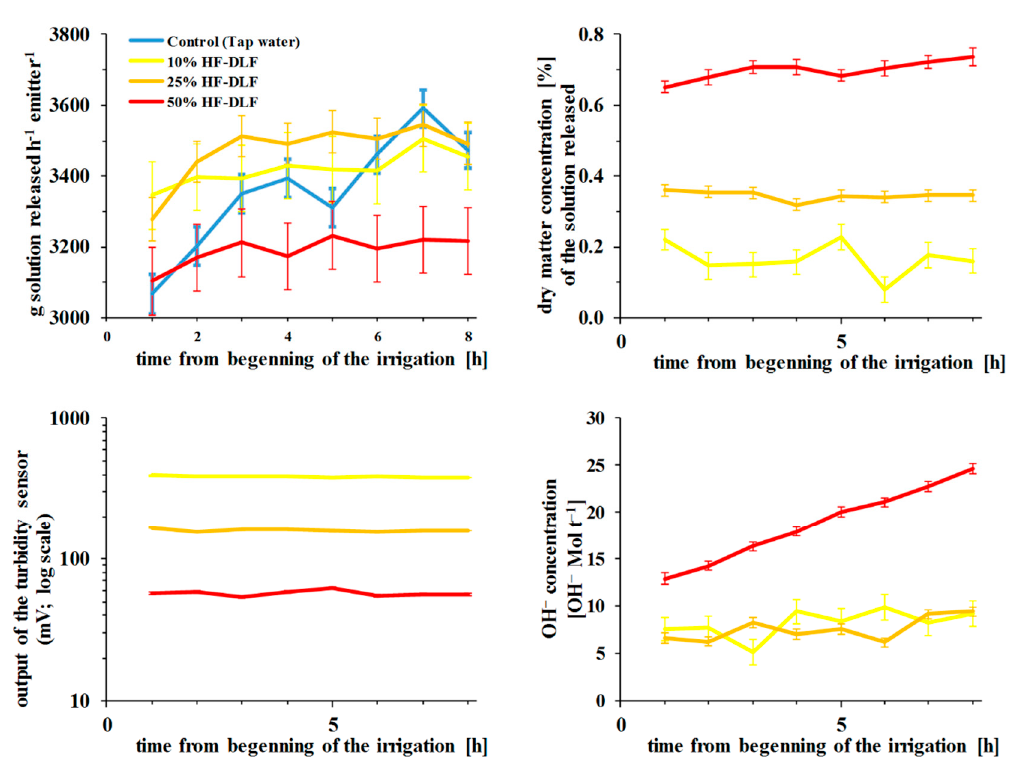
Figure 5. Amount of solution (tap water in the control and digestate liquid fractions (HF-DLF) diluted at the 10%, 25%, and 50%) released by the emitter each hour (upper left panel); dry matter concentration of the DLF released (upper right panel); turbidity of the HF-DLF released (lower left panel); and amount of OH − ions released per ton of water released each hour. Data are LSmeans ± LSmeans standard error estimates. For post-hoc comparisons and raw data see Supplementary Material Table S3.